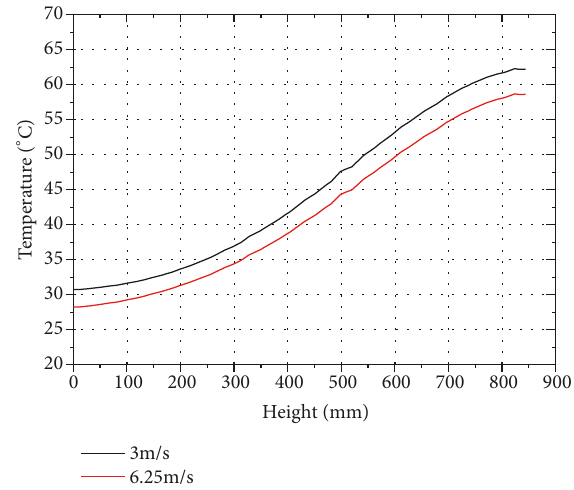
Figure 27: The temperature contrast of front plate between Test B1 and FS1.